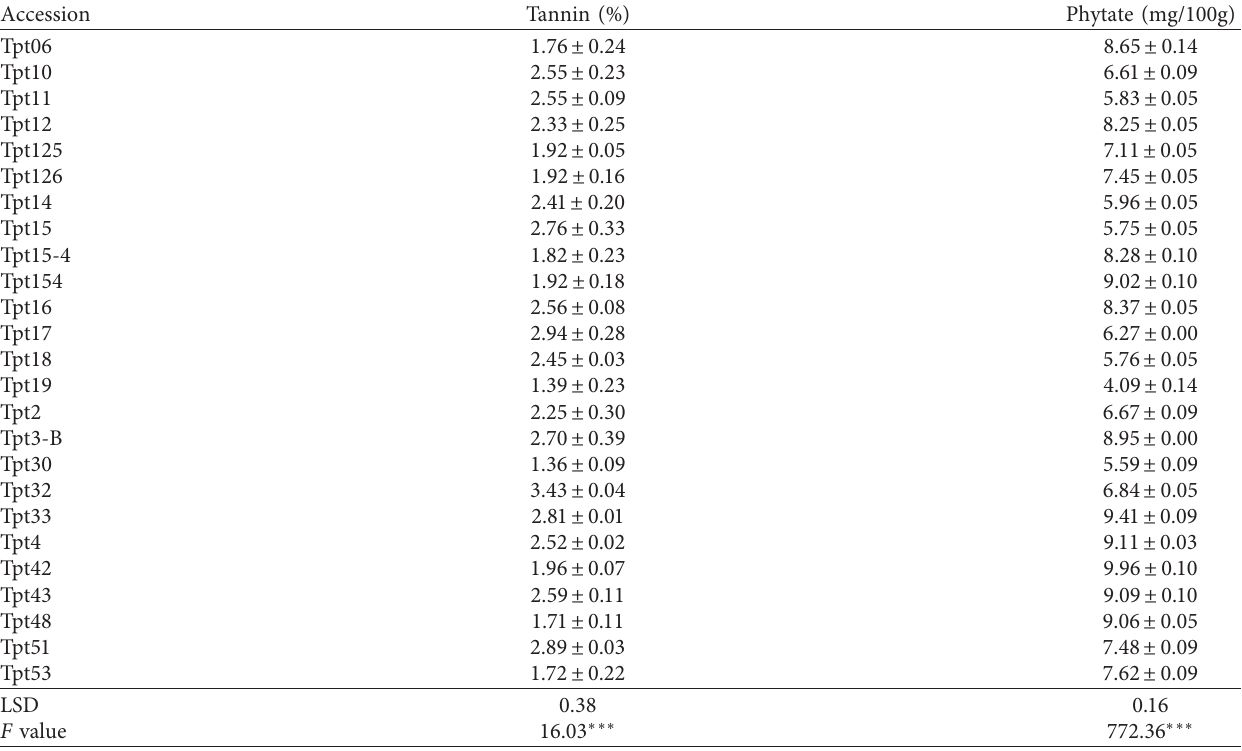
Table 5: Tannin and phytate concentration (means ± standard deviation) of unprocessed